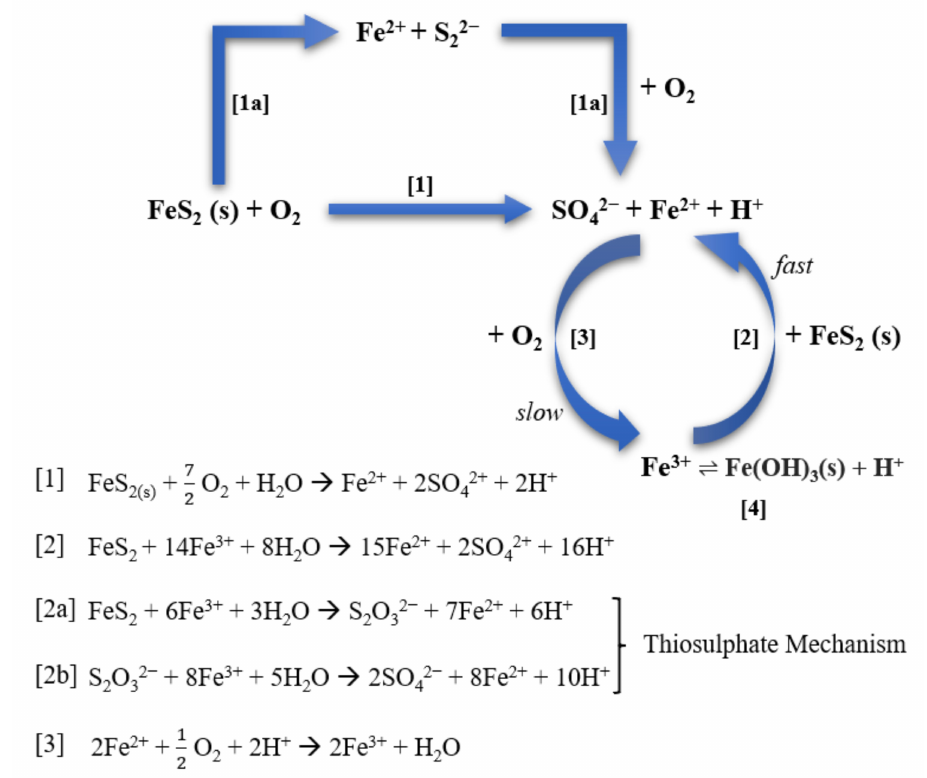
Figure 5. Schematic cycle of the pyrite oxidation mechanism with the associated reactions, highlight- ing the importance of bacterial regeneration of Fe 3+ to the further oxidize pyrite